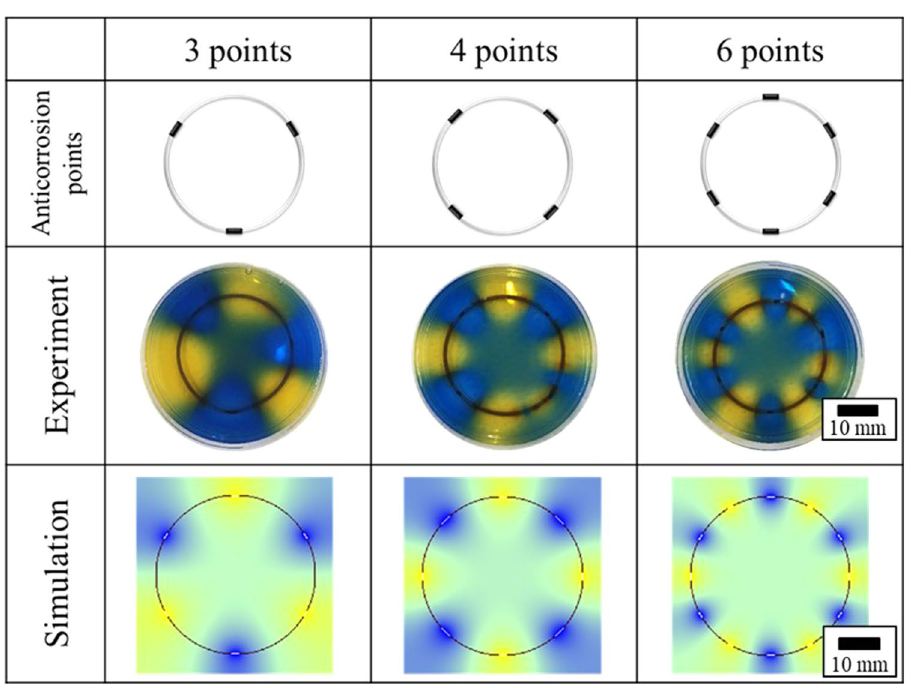
Figure 6. Image of observation and simulation for ion concentration distribution during AiS reaction (24